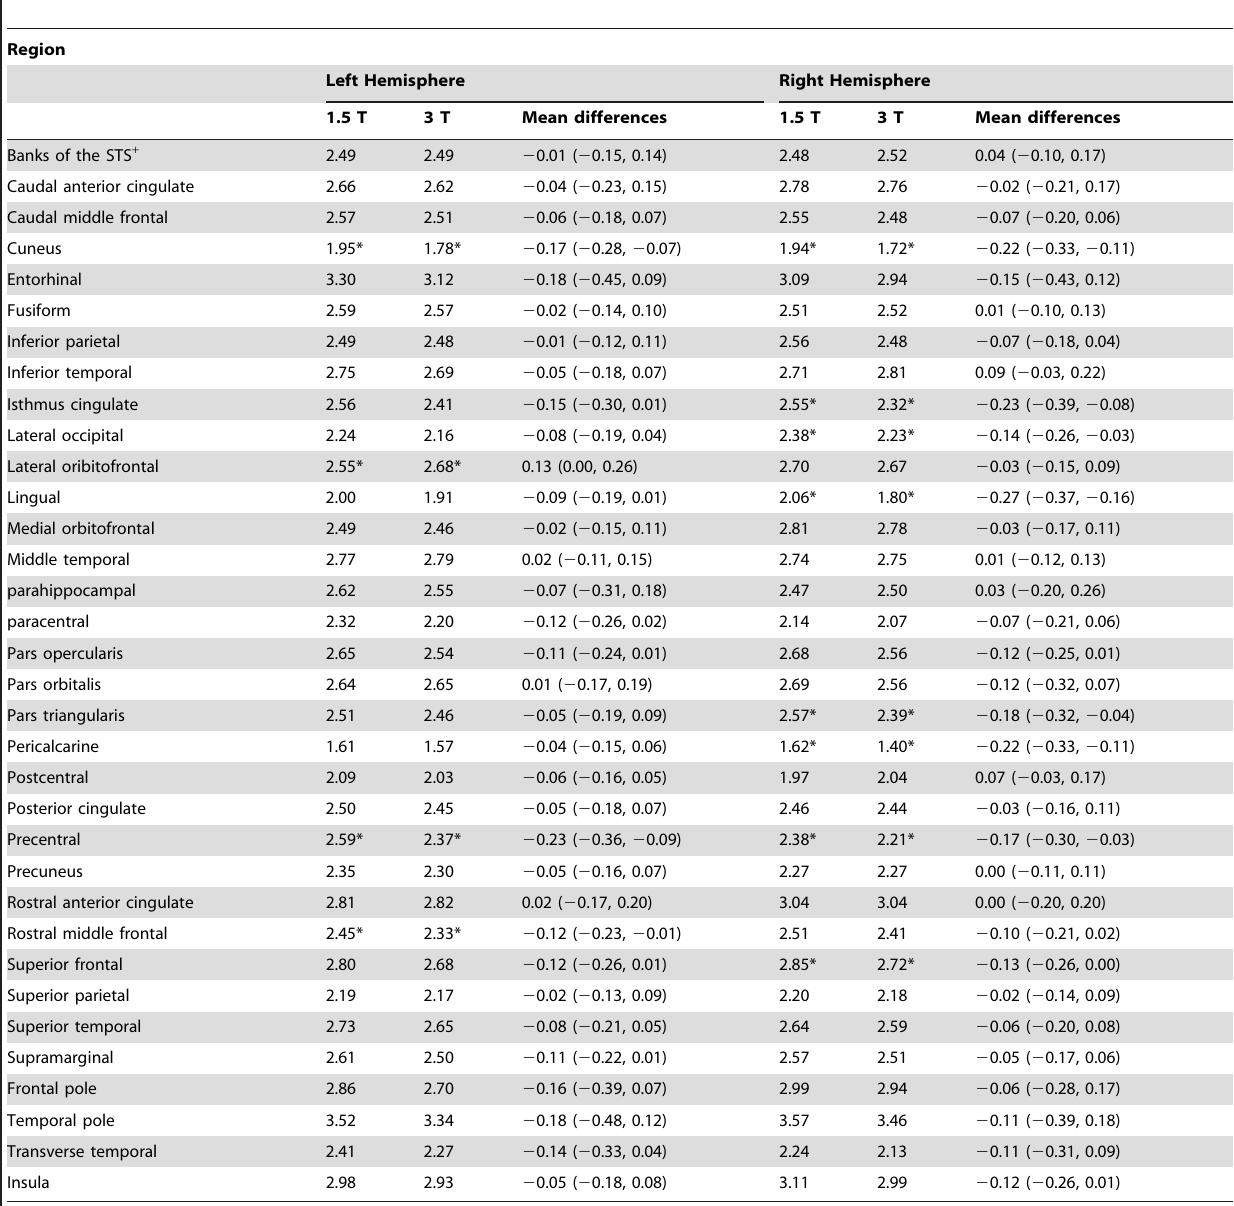
Table 7. Adjusted means and mean differences (95% confidence interval) of regional cortical thickness between 1.5 T and 3 T for females in the age group 56–80 after controlling for confounding